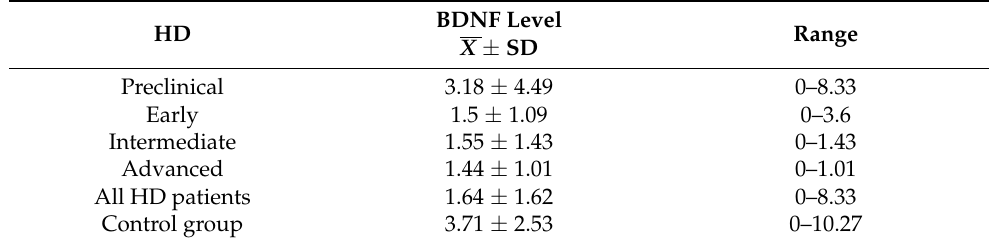
Table 2. Plasma levels of BDNF in study group divided into HD stages and control group.